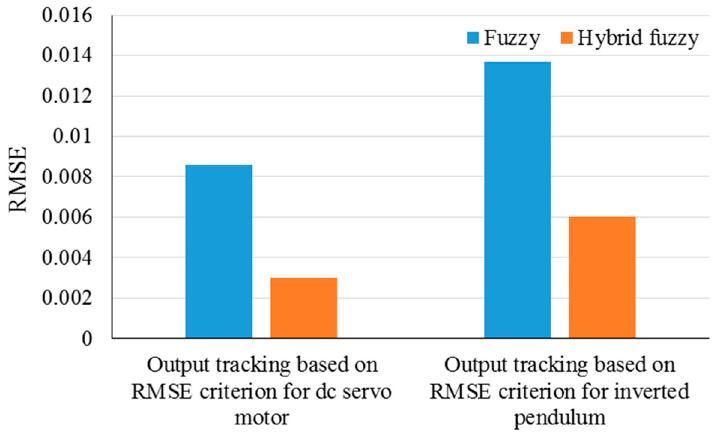
Figure 11. Results for the study by Li et al. (2005) [65].